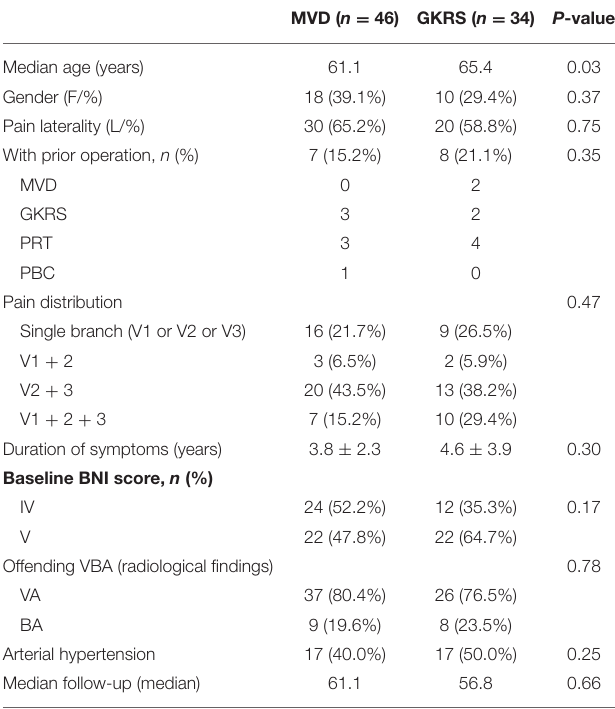
scores III to V were defined as unfavorable outcomes. The BNI TABLE 1 | Baseline characteristics of patients with VBD-TN in the MVD group and GKS